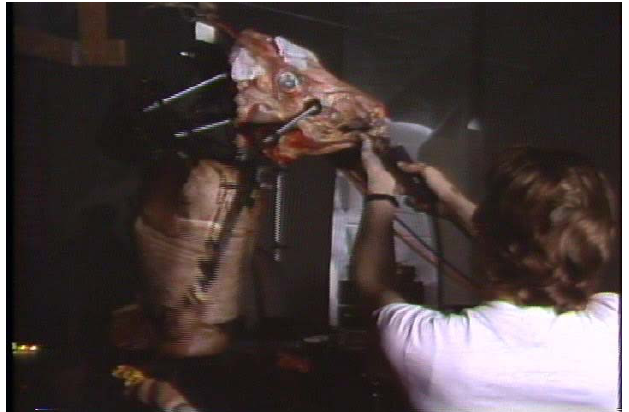
Figure 5. Piggly ‐ Wiggly ( left ) and Rabot ( right ) by Mark Pauline, 1981. Hog’s head, rabbit, and mechanics. Courtesy of the artist. © Survival Research Labs (www.srl.org).